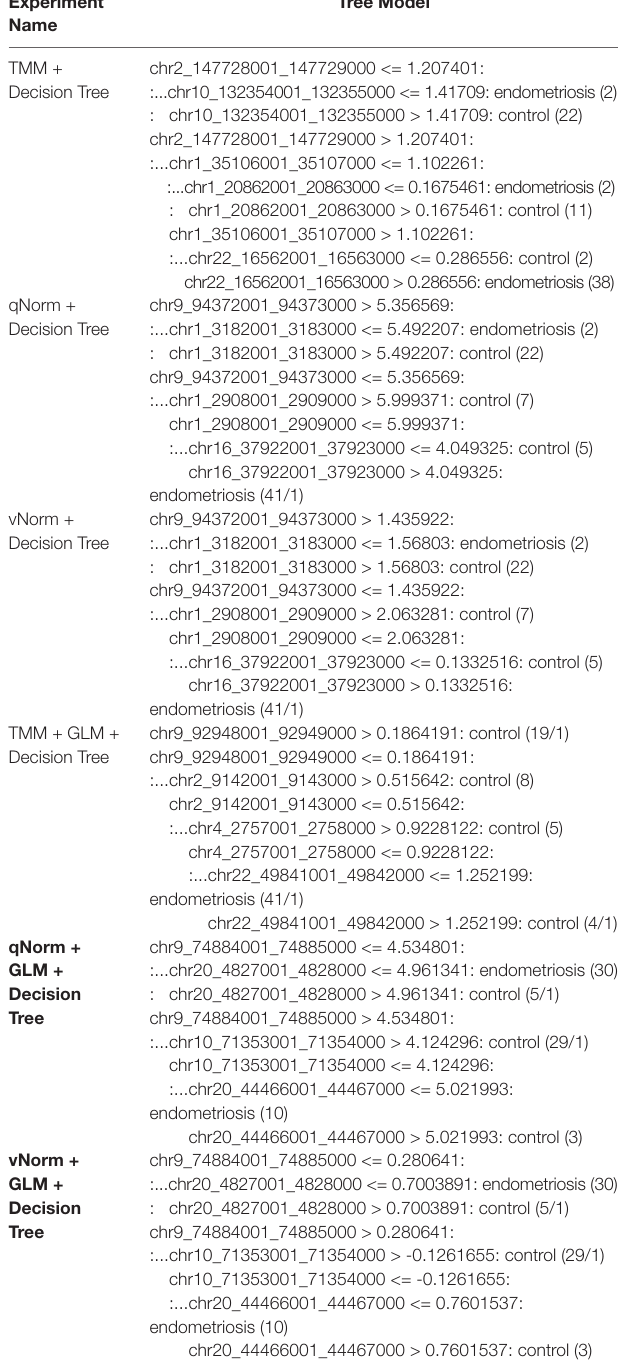
TABLE 6 | Decision tree models using methylomics